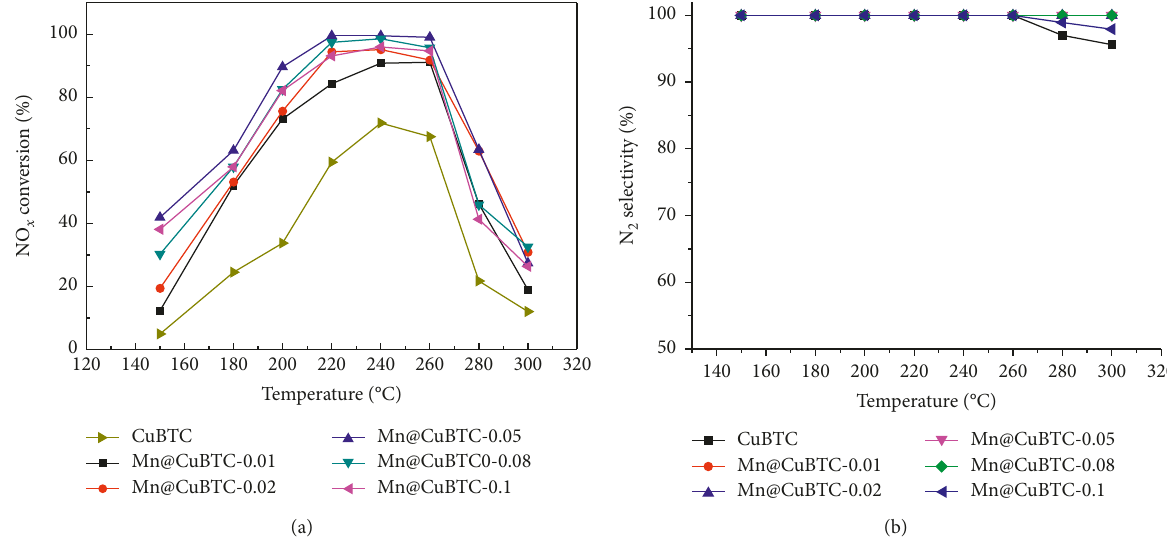
Mn@CuBTC-0.1Mn@CuBTC0-0.08Mn@CuBTC-0.05 Figure 3: NO conversion efficiency (a) and N 2 selectivity (b) of CuBTC and Mn@CuBTC-X catalysts as a function of temperatures. Reaction conditions: 500 ppm NO, 500ppm NH 3 , 5 vol.% O 2 , and N 2 balance, GHSV � 30,000h − 1